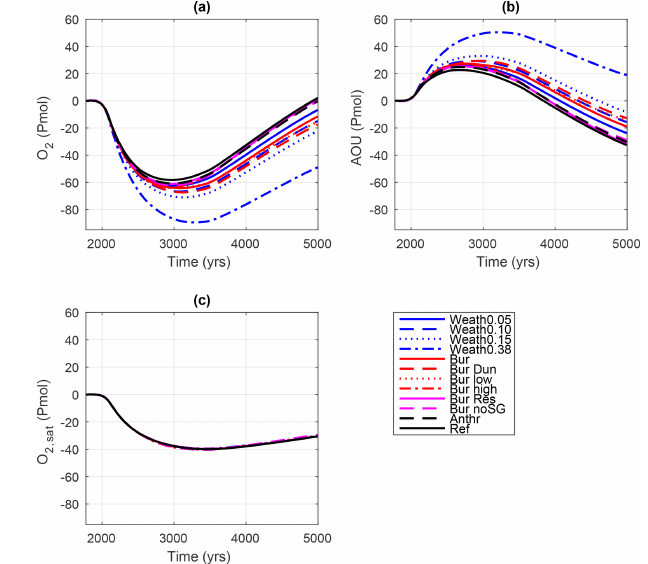
Figure 9. Anomalies of globally integrated (a) O 2 content, (b) ap- parent oxygen utilization (AOU) and (c) oxygen saturation (O 2 , sat ) in Pmol O 2 . Simulation descriptions can be found in Table 1.